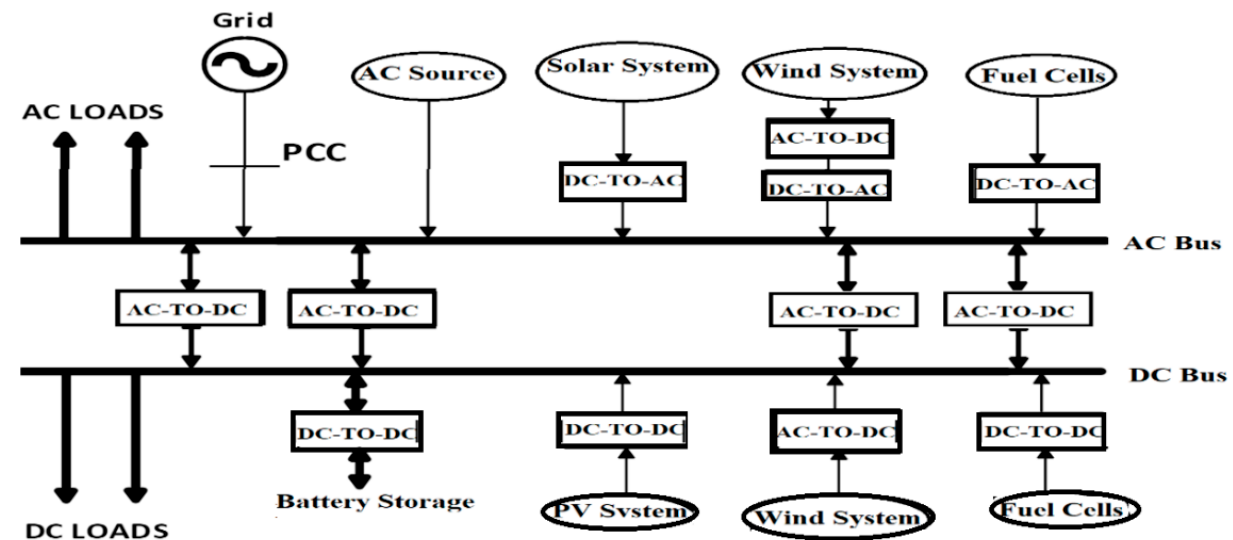
Figure 3. Hybrid/Advance Microgrid structure.